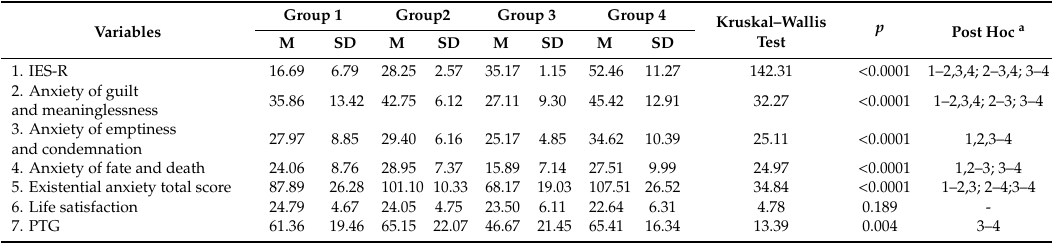
Table 3. Descriptive statistics (M,SD) for the study variables.